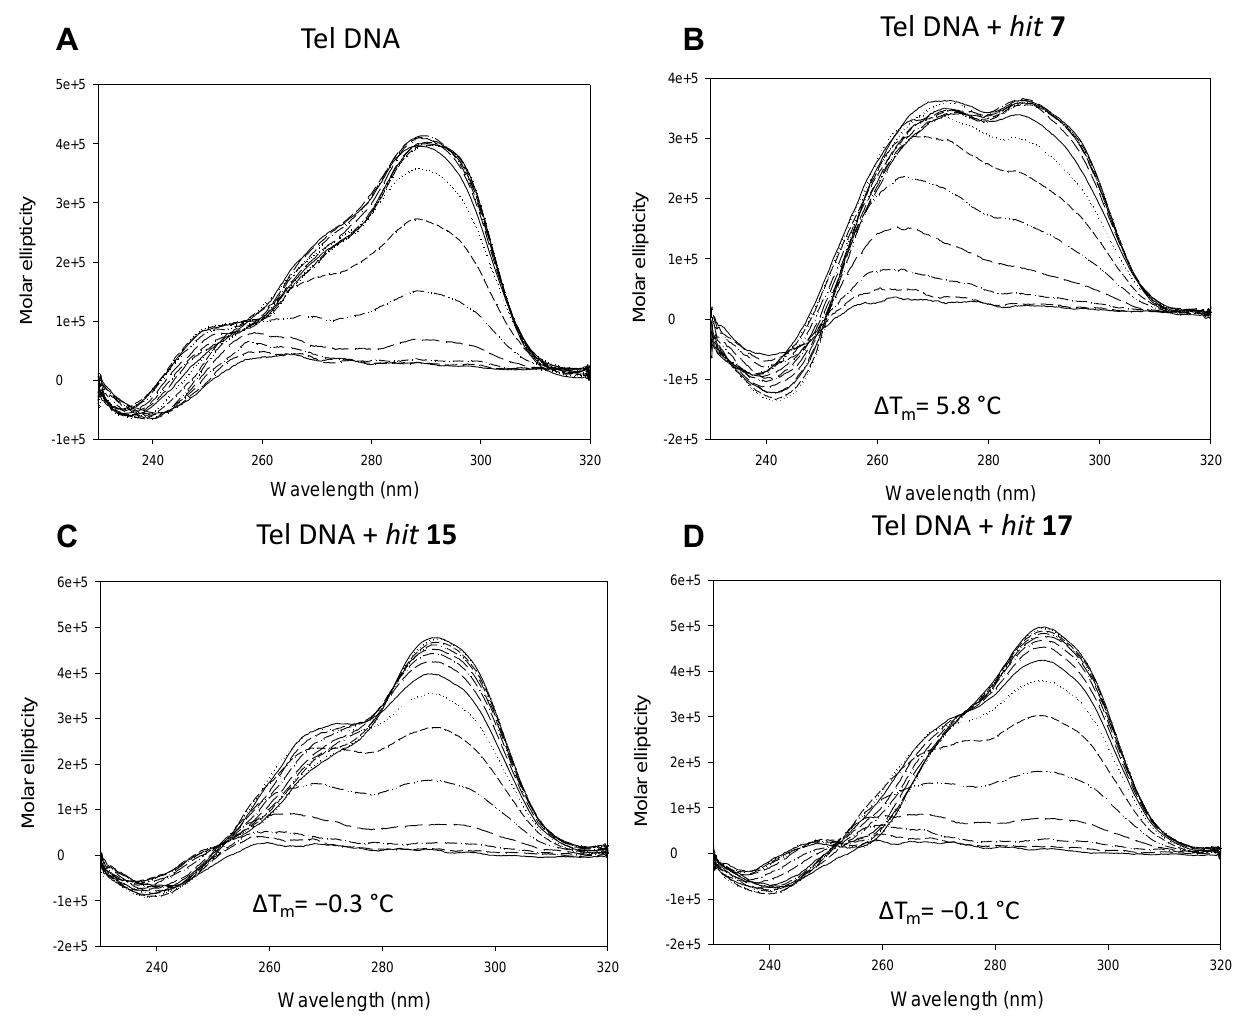
Figure 3. The CD thermal unfolding spectra of the nucleic acid Tel G4 4 μM in 100 mM K + alone ( A ) and in the presence of the hit 7 16 μM ( B ), hit 15 16 μM ( C ), and hit 17 16 μM ( D ). TERRA G4 showed a prevalently parallel topology, with a maximum peak of around 260 nm and a shoulder of around 300 nm, and T m of 75.2 ± 0.7 °C. Incubation with hits 7 , 15, and 17 did not alter its topology but led to great stabilization of the structure, with hit 7 being the best stabilizer (ΔT m 11.2 °C), followed by hit 15 (ΔT m 9.5 °C) and hit 17 (ΔT m 7.7 °C) (Figures 4 and S9). These in vitro data are in perfect agreement with our MD simula- tions.